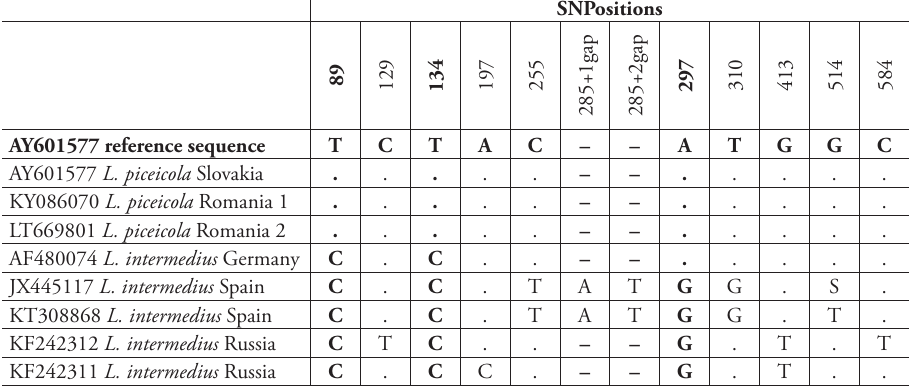
Table 4. The variable positions in D2-D3 28S rDNA control region sequences of Longidorus piceicola and L. intermedius. The L. piceicola sequence from Slovakia (Acc. no AY601577) was used as a